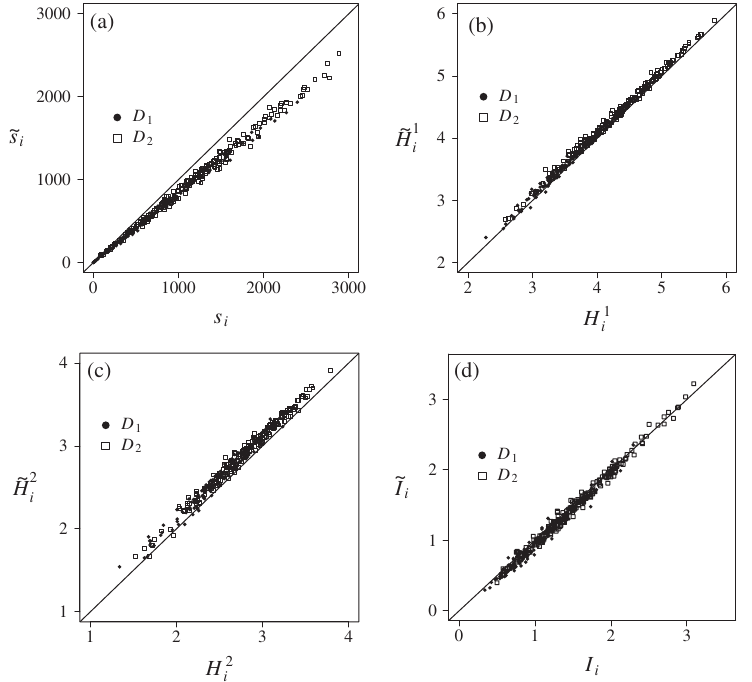
FIG. 16. Comparison between the interpolated and original data for data sets D (c) conditional entropy, and (d) mutual information for the interpolated data with m ¼ 1 are plotted against those without interpolation (i.e., original data sets).